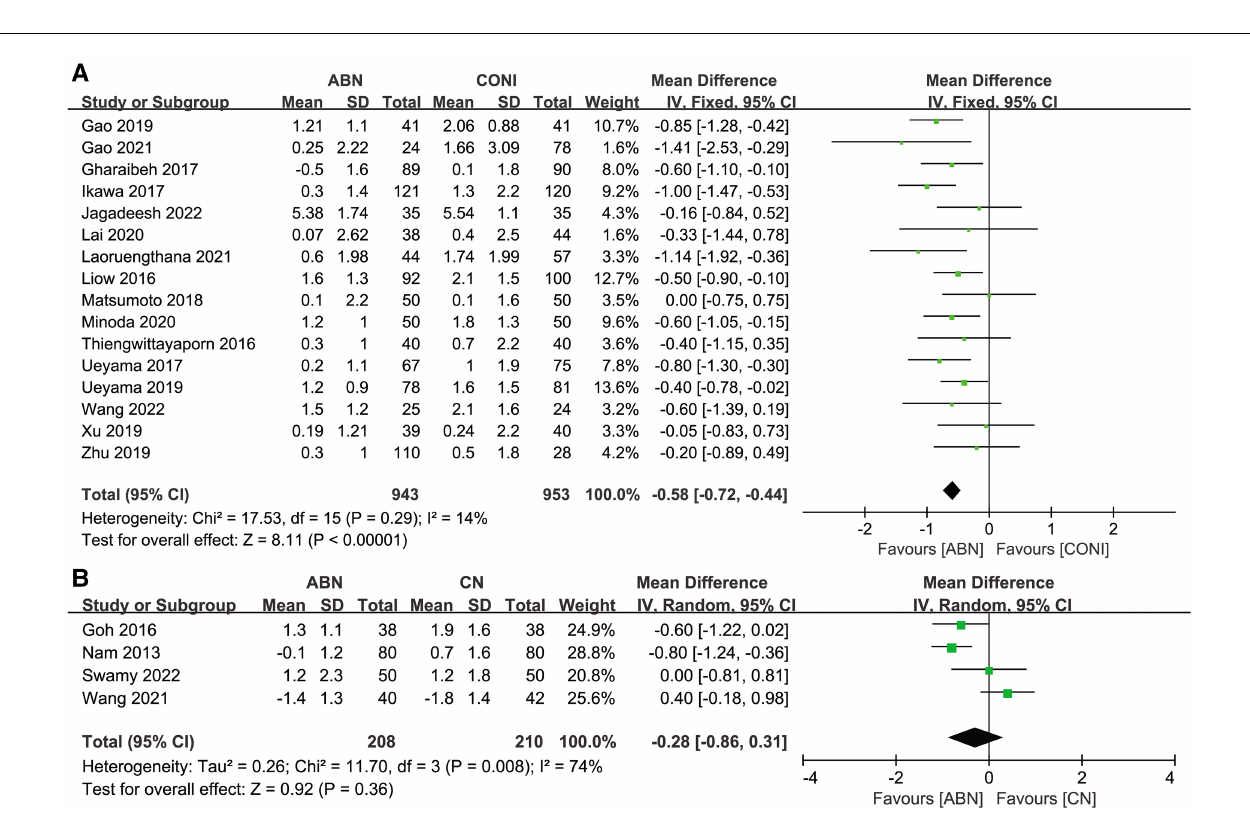
FIGURE 5 Forest plot of coronal femoral angle (CFA). ( A ) Accelerometer-based navigation (ABN) system vs. conventional instrumentation (CONI); ( B ) ABN system vs. computer navigation (CN)